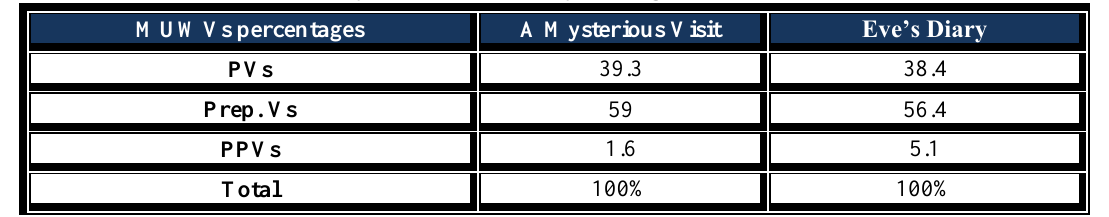
Table 3 – Comparison on MUWVs percentages between MV and